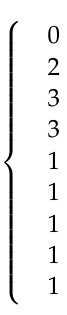
Figure 17. The state of the borehole at the end of the drilling operation during the second BHA run. The final cuttings bed was around 9-inch, which is significantly higher than the limits specified in Figure 16a. Therefore, to ensure safe tripping operations without getting stuck, and to prepare the well for casing and cementing operations, these cuttings needed to be removed. A 50-min circulation cycle was then performed, the resulting state of which is represented by Equation (20), and Figure 18. The final cuttings bed height was still close to the allowed limit, and therefore non-optimal, explaining the issues encountered during tripping, casing, and cementing.